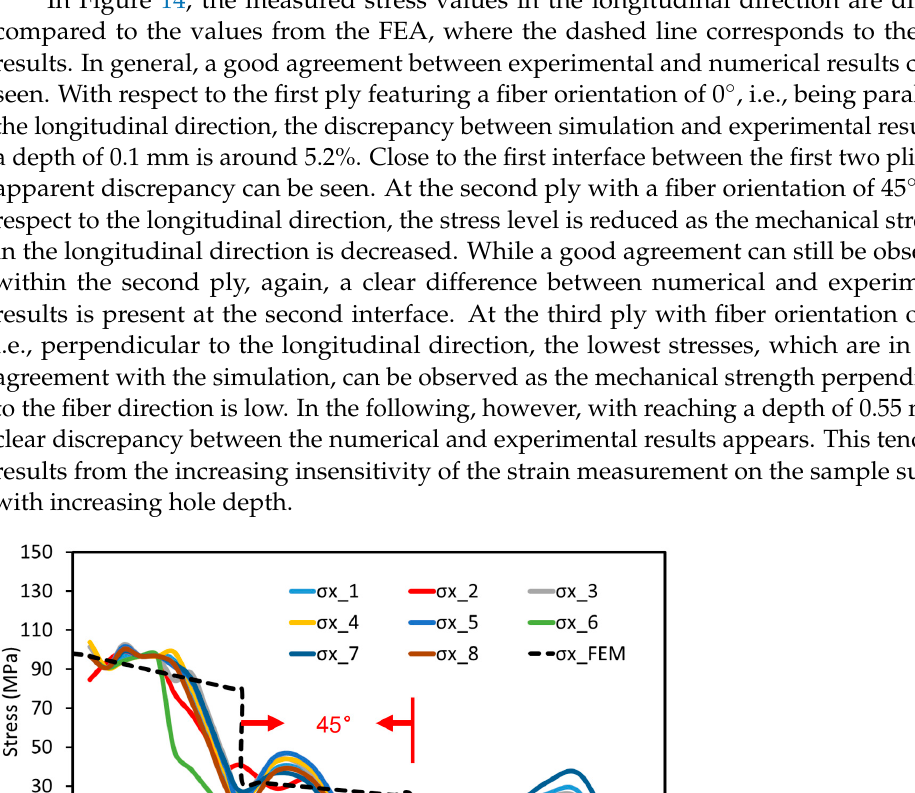
Figure 14. Validation of the residual stress measurements in the multidirectional CFRP sample based on the assessment of stresses introduced by superimposed load and a direct comparison to FEA. Solid lines show experimentally determined bending stress, while the dashed line illustrates the FEA results. See text for details.